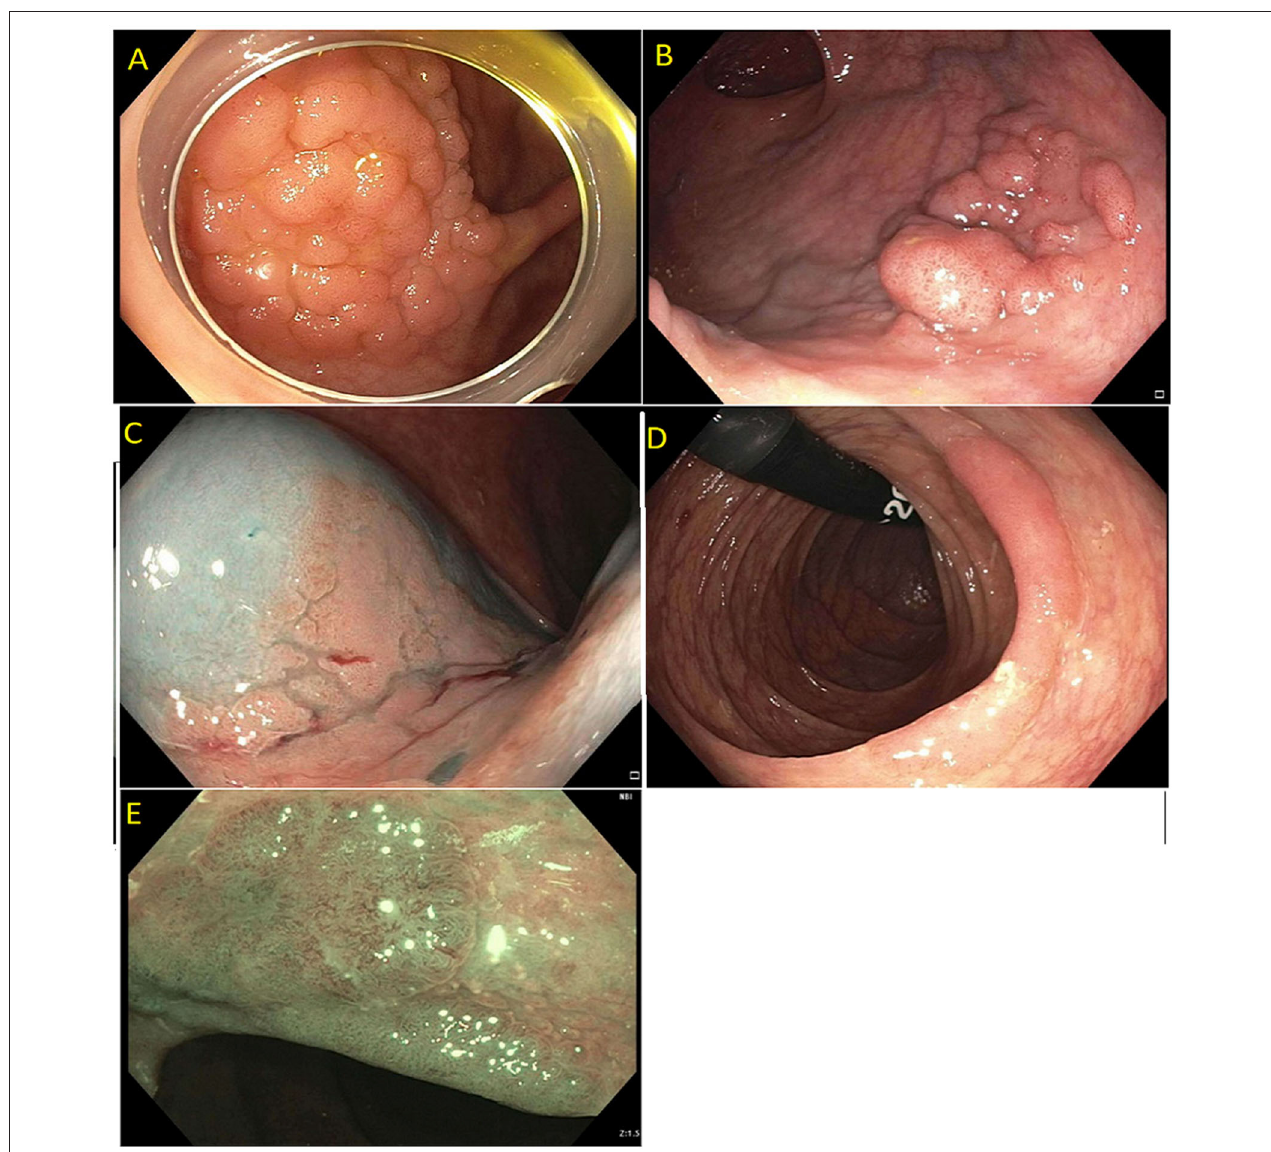
FIGURE 1 | (A) Granular lateral spreading lesion; (B) Granular lateral spreading lesion with dominant nodule; (C) Non-granular lateral spreading lesion. These lesion have a higher risk of fibrosis and invasive cancer. Polyp was tubular adenoma; (D) Non-granular lateral spreading lesion on white light; (E) Non-granular lateral spreading lesion on Narrow Band Imaging (NBI). Histology revealed a T1 adenocarcinoma.